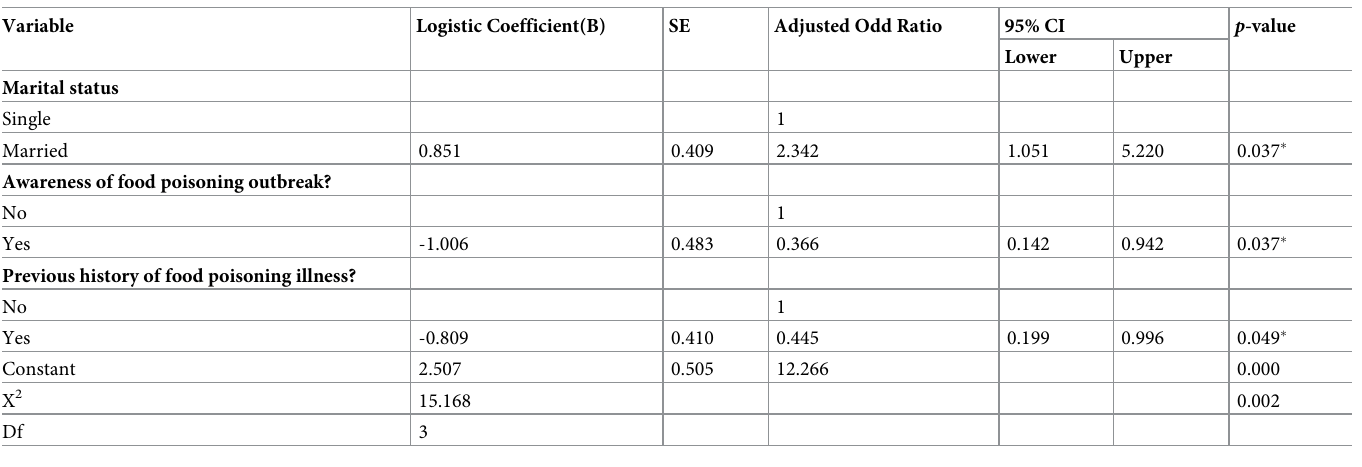
Table 10. Predictors influencing knowledge of respondents towards food